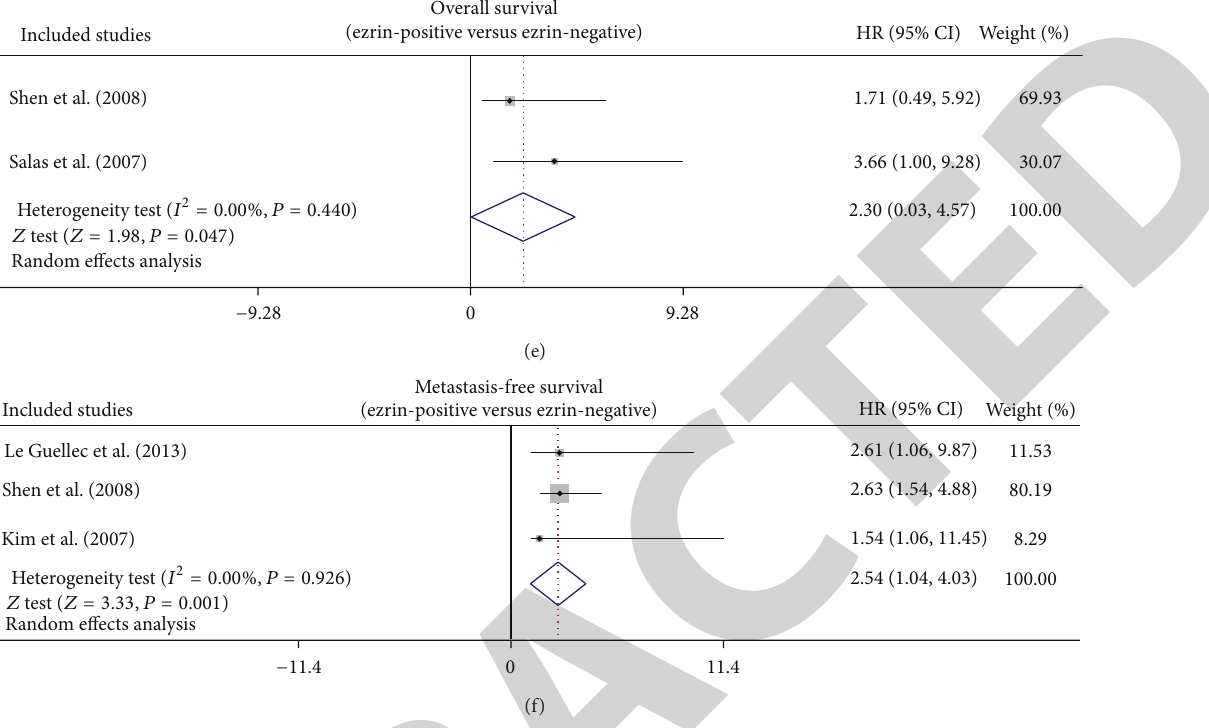
Figure 3: Forest plots for the correlations of ezrin expression with pathological characteristics and prognosis of